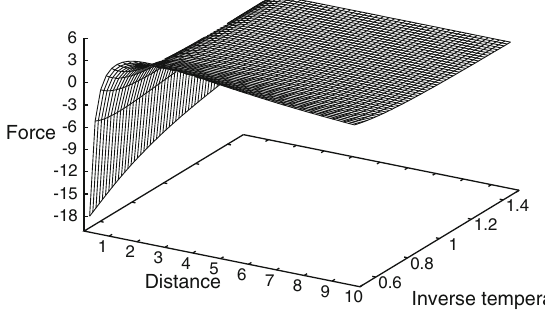
Fig. 4 Normalized Casimir force of a scalar field as a function of nor- malized separation and temperature. ¯ m is set equal to